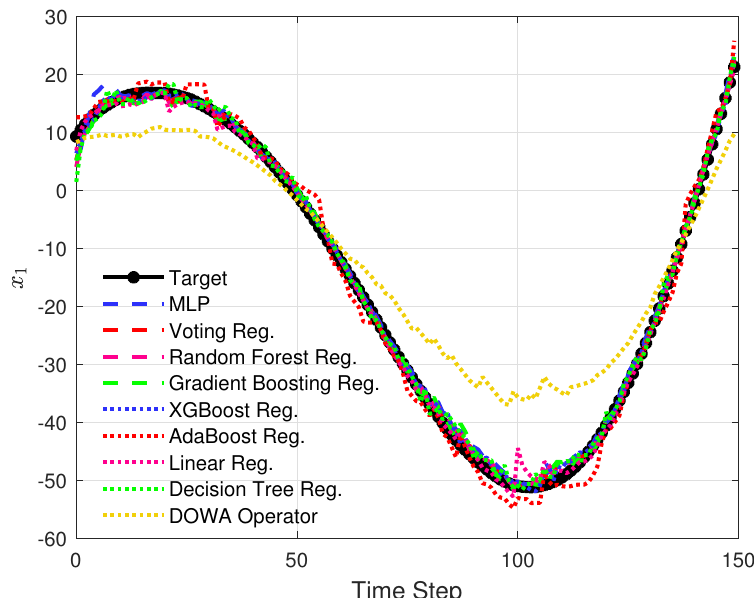
Figure 10. Fusion results for one Monte Carlo simulation for state 1.